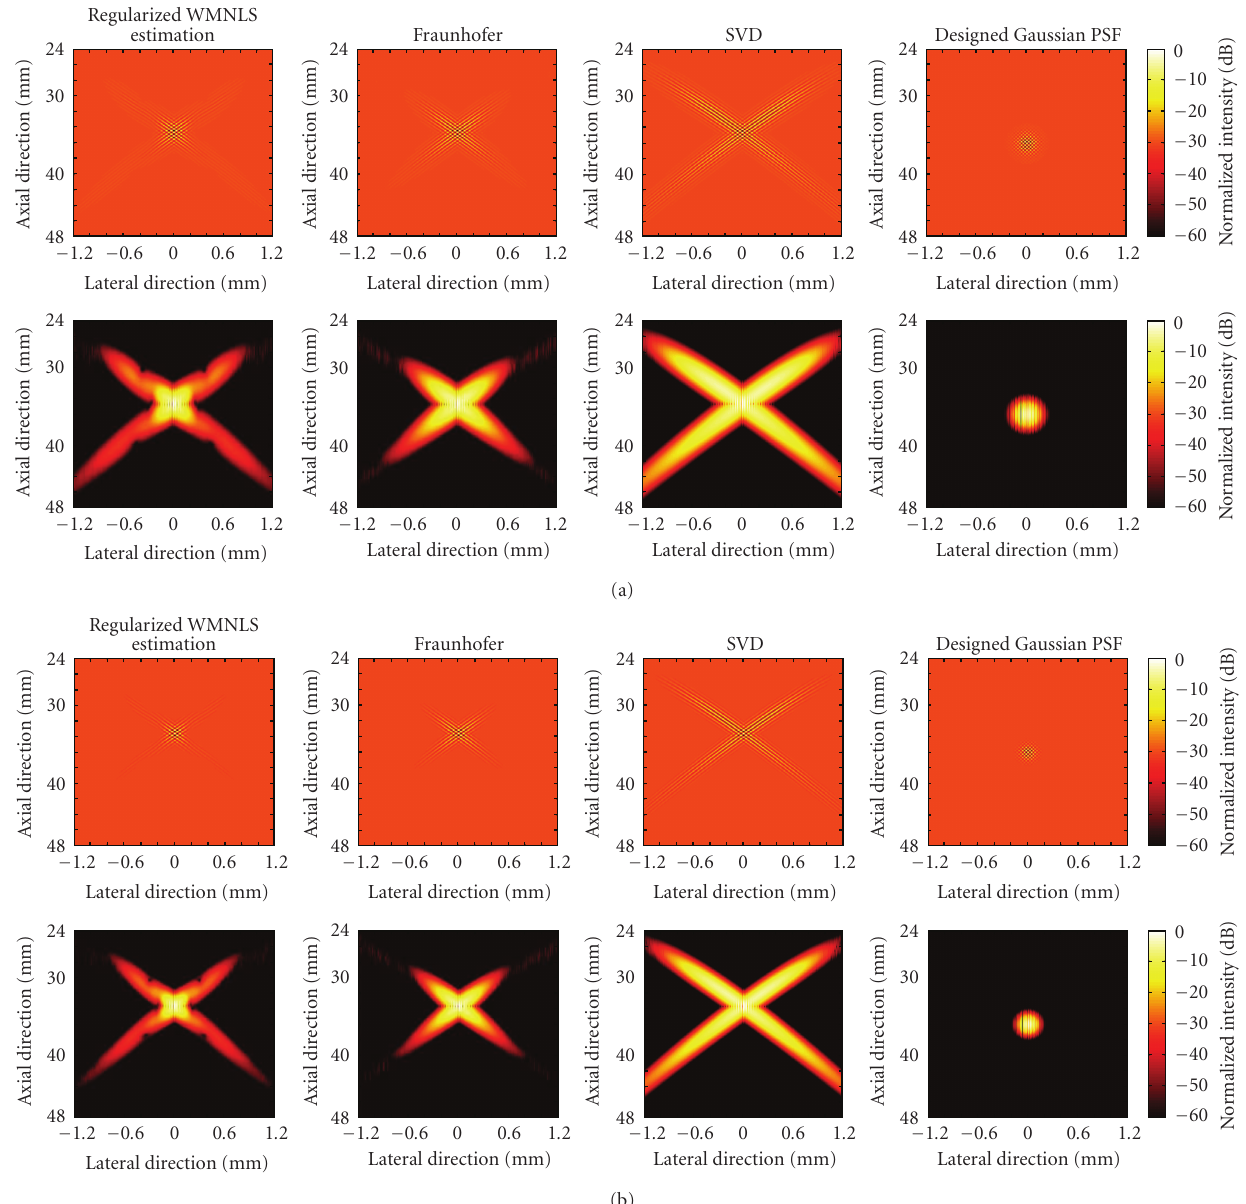
Figure 2: Designed Gaussian-type PSFs and PSFs obtained using apodization functions obtained with a regularized WMNLS estimation, a Fraunhofer approximation, and SVD for (a) σ y = 0.8 and (b) 0.6 mm.